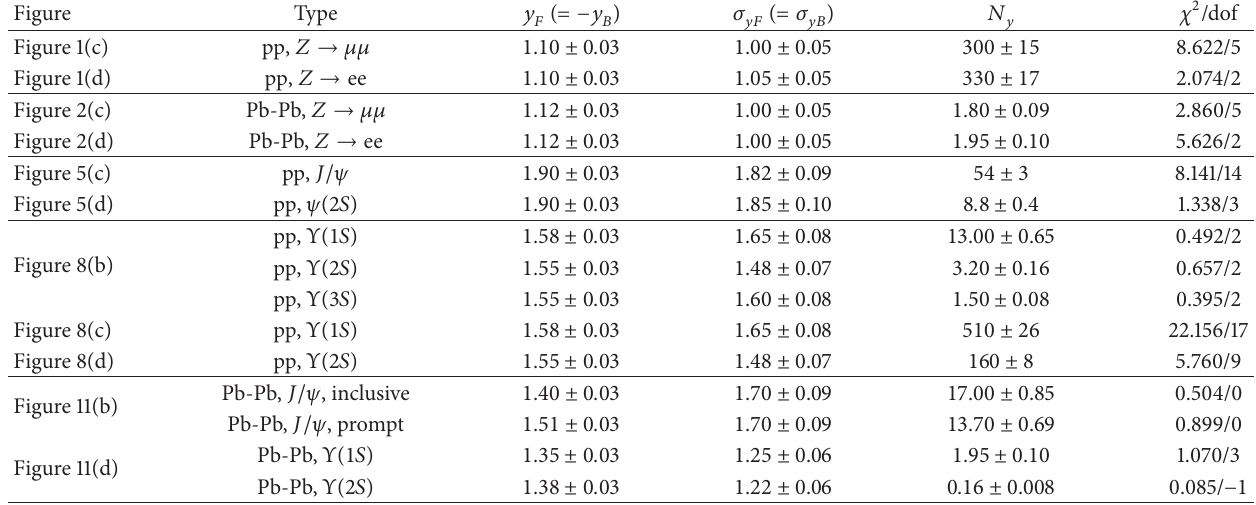
Table2:Valuesoffreeparameter[ 𝑦 𝐹 ( = −𝑦 𝐵 )and 𝜎 𝑦𝐹 ( = 𝜎 𝑦𝐵 )],normalizationconstant( 𝑁 𝑦 ),and 𝜒 2 /dofcorrespondingtothetwo-component Gaussian distribution in Figures 1(c), 1(d), 2(c), 2(d), 5(c), 5(d), 8(b), 8(c), 8(d), 11(b), and 11(d). In some cases, dof is less than